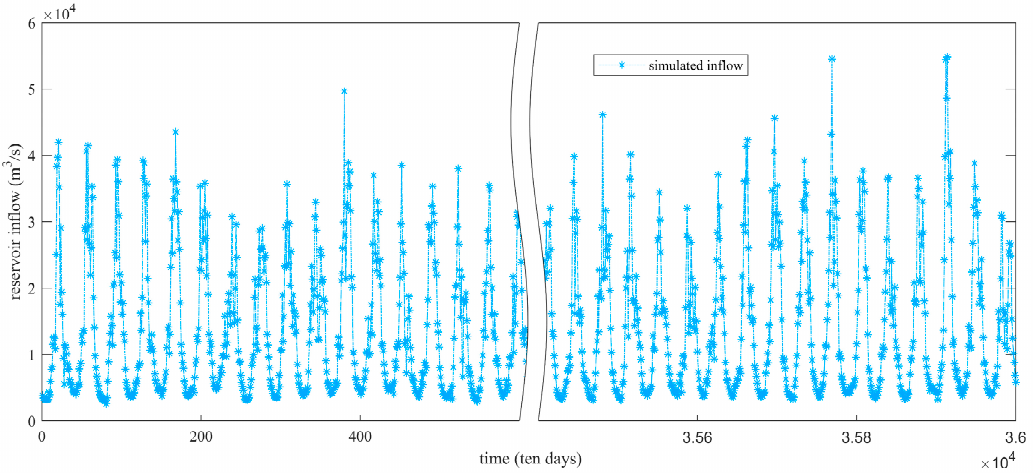
Figure 7. One thousand-year simulated inflow series with a ten-day time step.